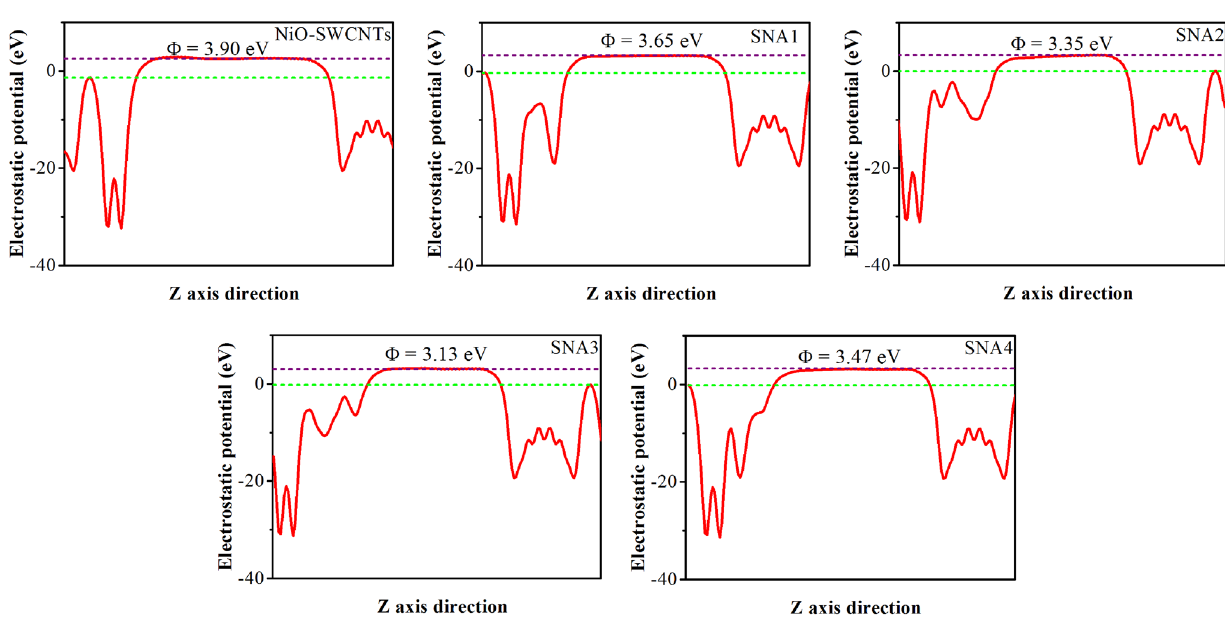
Figure 12. The calculated work function ( (cid:31) ) of N -acetylcysteine molecule adsorption on the NiO–SWCNTs